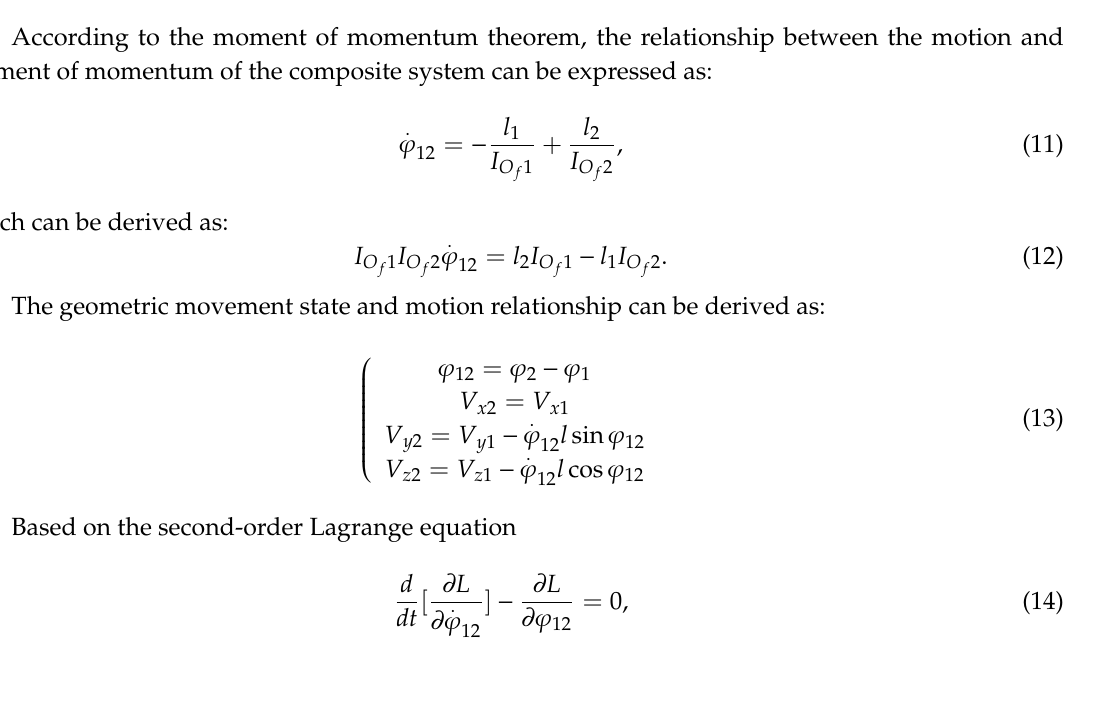
Figure 5. Internal relative movement of the multibody system.